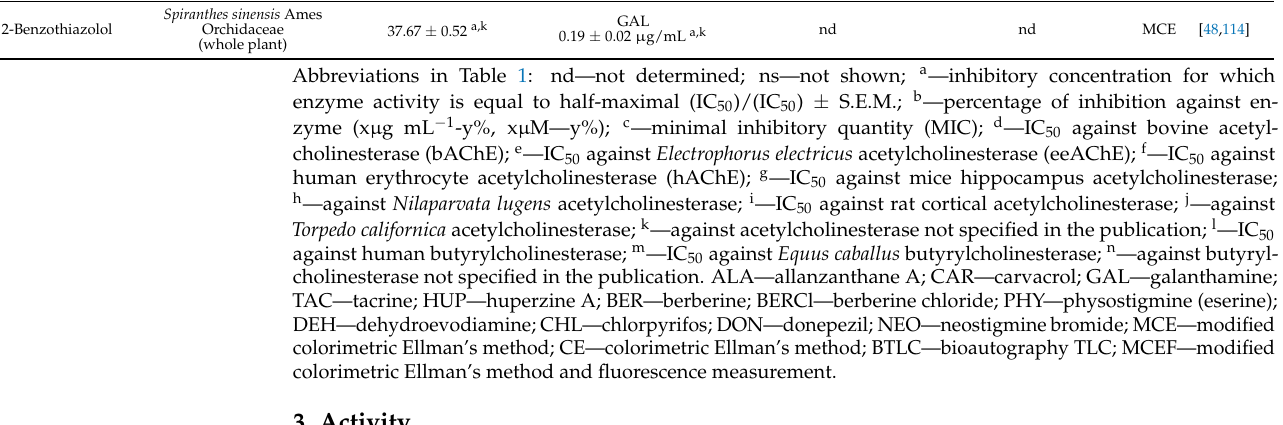
Abbreviations in Table 1: nd—not determined; ns—not shown; a —inhibitory concentration for which enzyme activity is equal to half-maximal (IC 50 )/(IC 50 ) ± S.E.M.; b —percentage of inhibition against